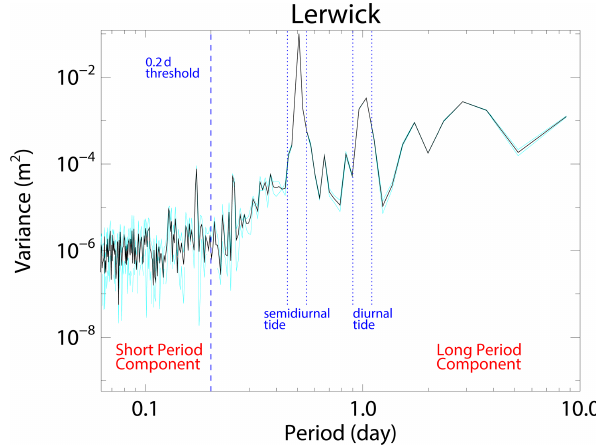
Figure 4. Sample spectrum of the 13 day time series of water level for Lerwick. The 0.2d threshold separating the short period and long period components of the time series reconstructions is shown, as well as the thresholds defining the diurnal and semidiurnal com- ponents that were used to de-tide the time series. The uncertainty in the spectrum (light blue line) is calculated as the standard deviation of three spectra derived from re-sampling the time series at every third